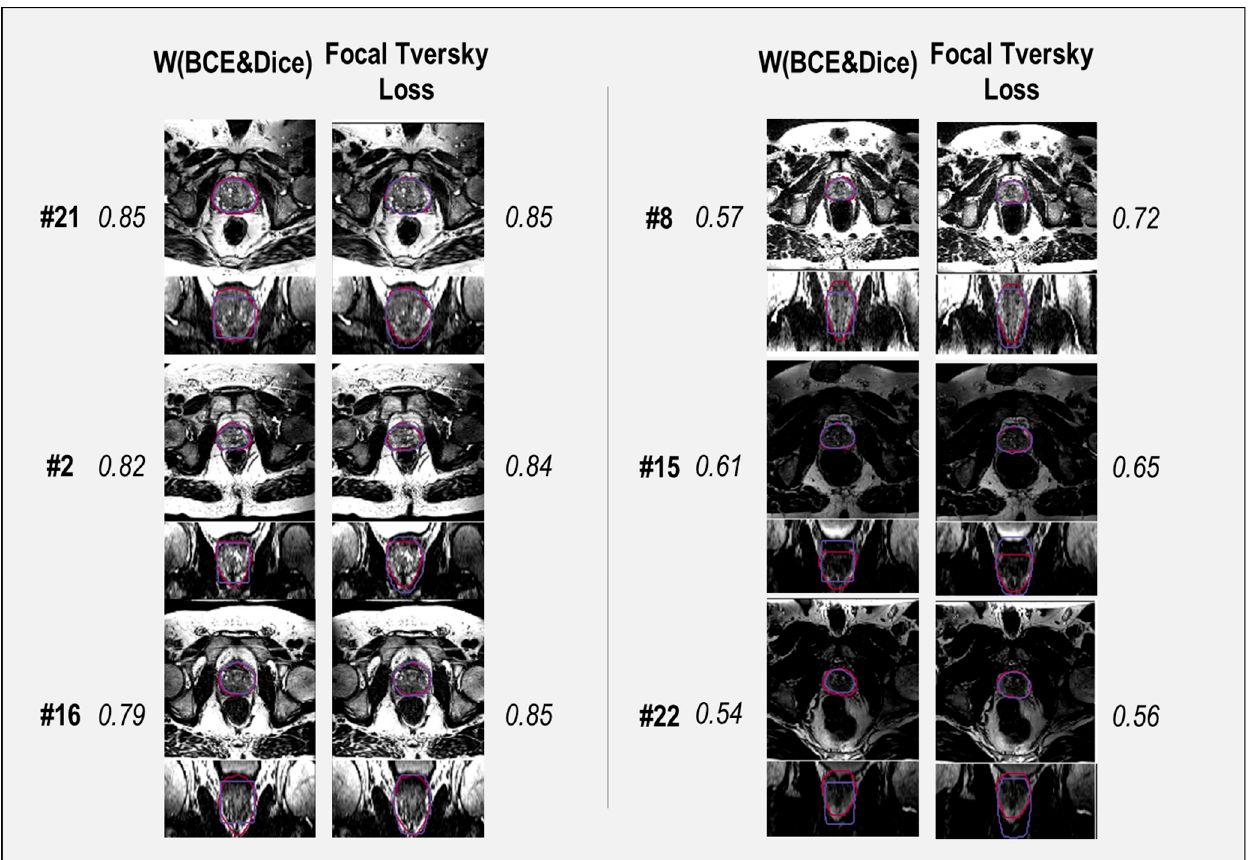
Figure 9. Outputs of two models (Focal Tversky and W (BCE + Dice)) for 6 patients (each patient identified by a number, e.g., #21 represents patient 21) in the axial (top image) and coronal views (bottom image for each patient), demonstrating both high and low performances, measured in Dice scores (shown adjacent to each image set). The ground truth is represented by the red contour, the model’s prediction contour is shown in purple.